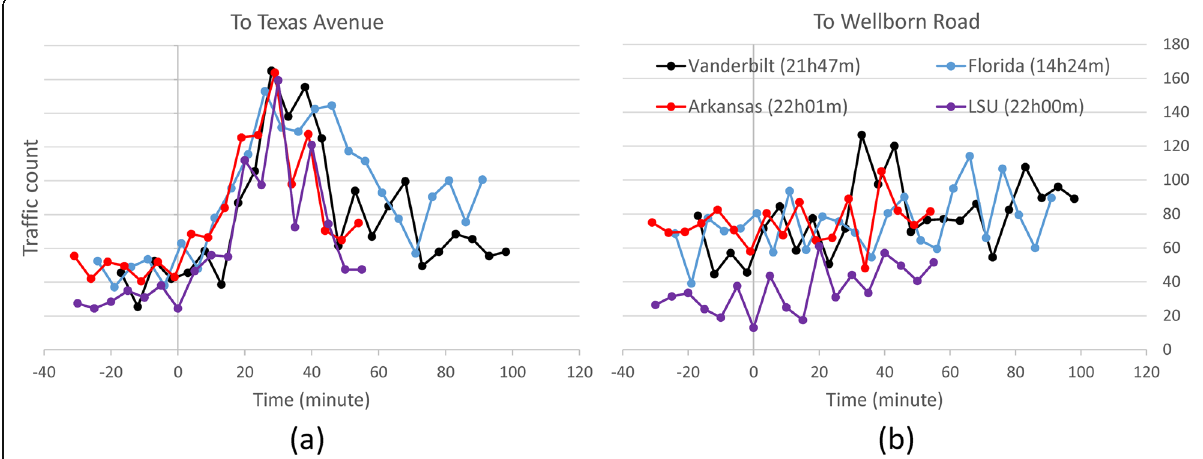
Fig. 8 Post-game traffic analysis on University Drive. Legend: opponent team (game ending time). All data are synchronized at the end of the games, denoted by t =